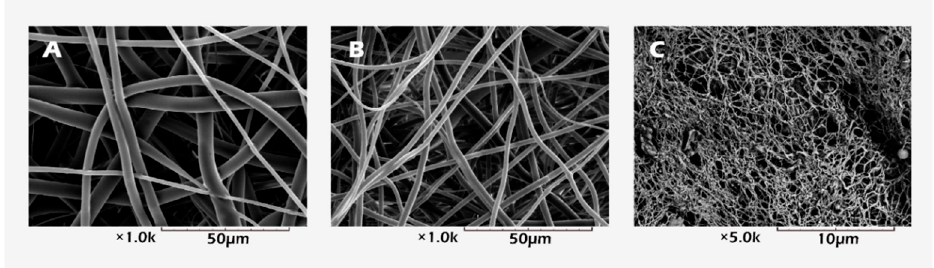
Figure 8. SEM images of the ( A ) coarse, ( B ) fine (1000× magnification) electrospun PLLA mats, and ( C ) decellularized testicular tissue (5000× magnification).